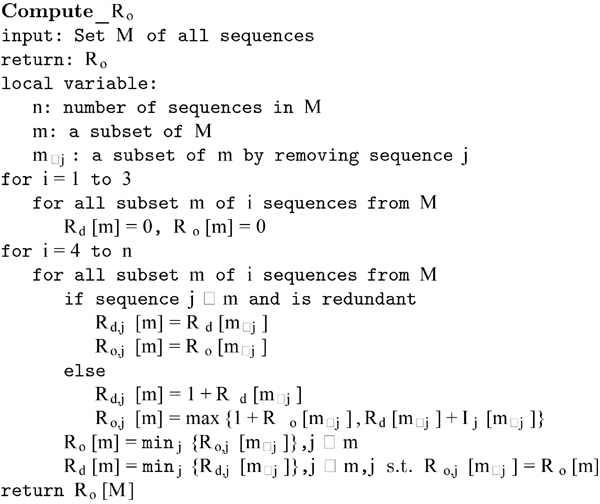
An algorithm for computing Ro.